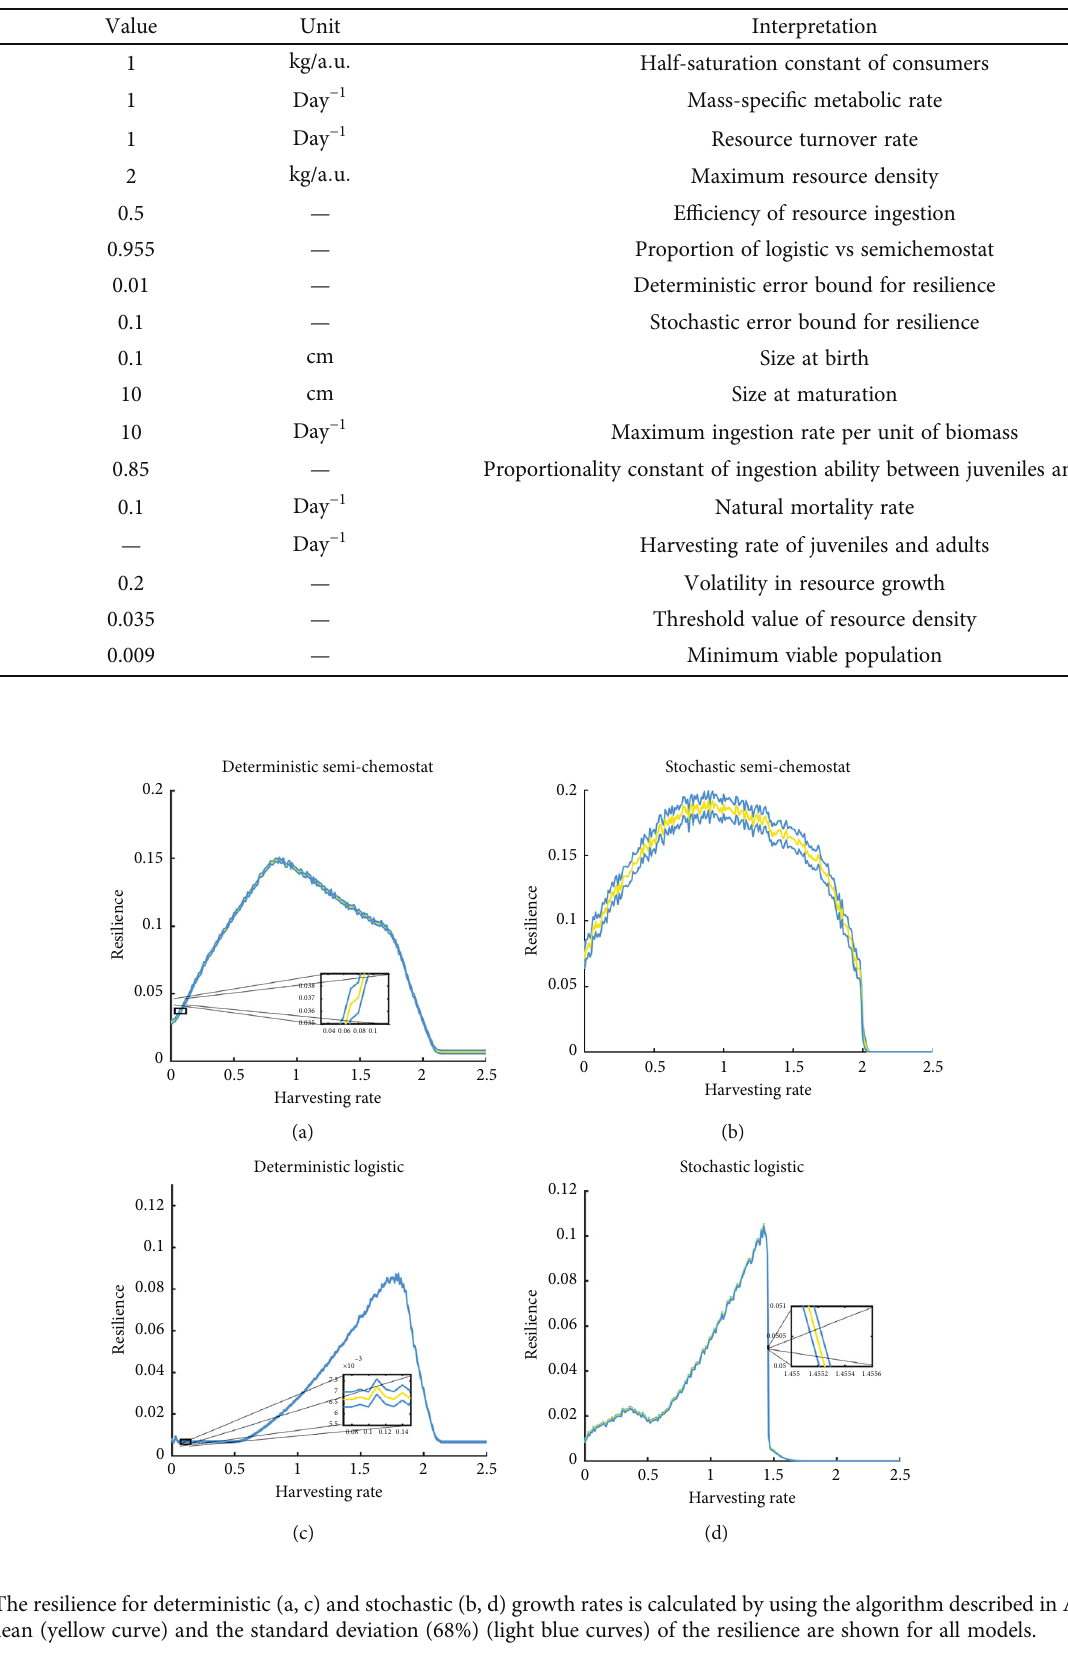
Table 2: Ecological and economic parameters. The column Unit is the unit dimensions before rescaling into nondimensional parameters.